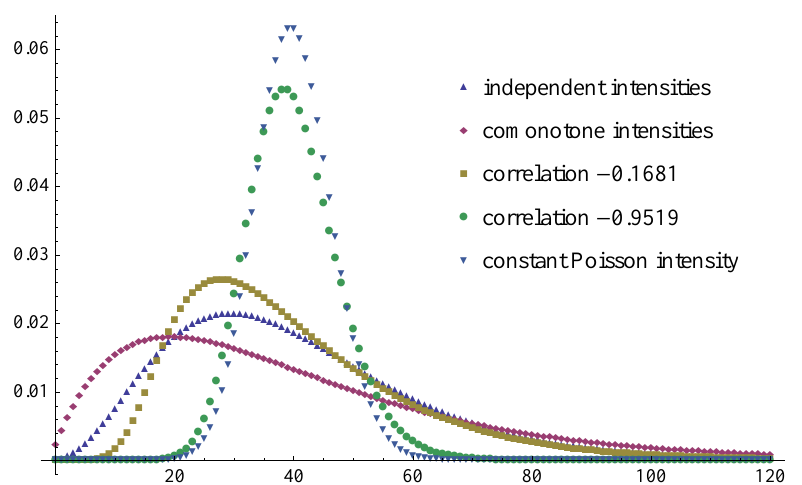
Figure 2. Probability mass functions of the N 0 -valued portfolio loss ˆ S for different dependence structures for the two claim cause intensities Λ 1 and Λ 2 satisfying E [ Λ 1 ] = E [ Λ 2 ] = 1 and Var ( Λ 1 ) = Var ( Λ 2 ) = 1/2 as discussed in Section 4.1. We take V = R . The claim size equals 1 = X s = δ in all cases, i.e., X s 1 . For comparison, also the case 2 1 distribution with expectation 40, is